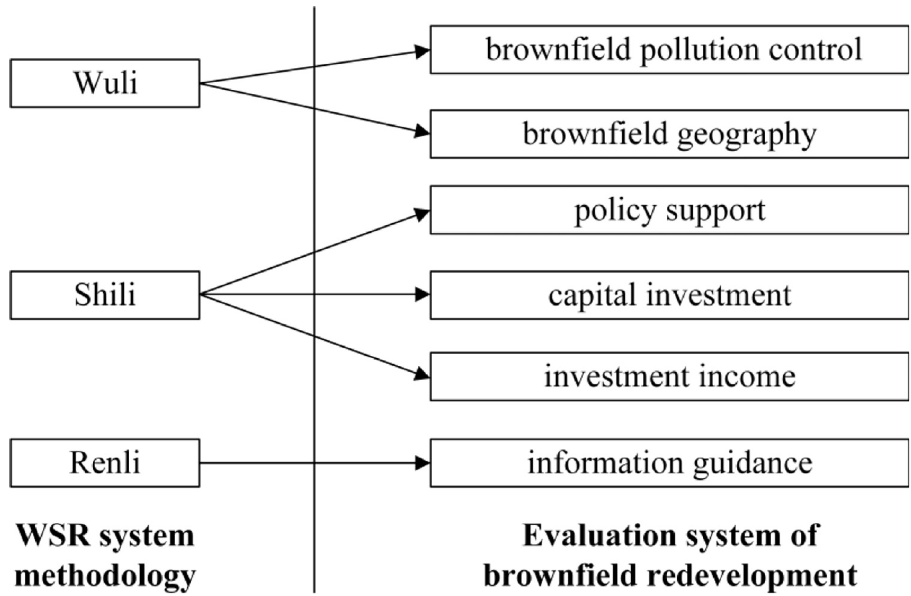
Fig 1. Relationship between the brownfield redevelopment evaluation system and the WSR system